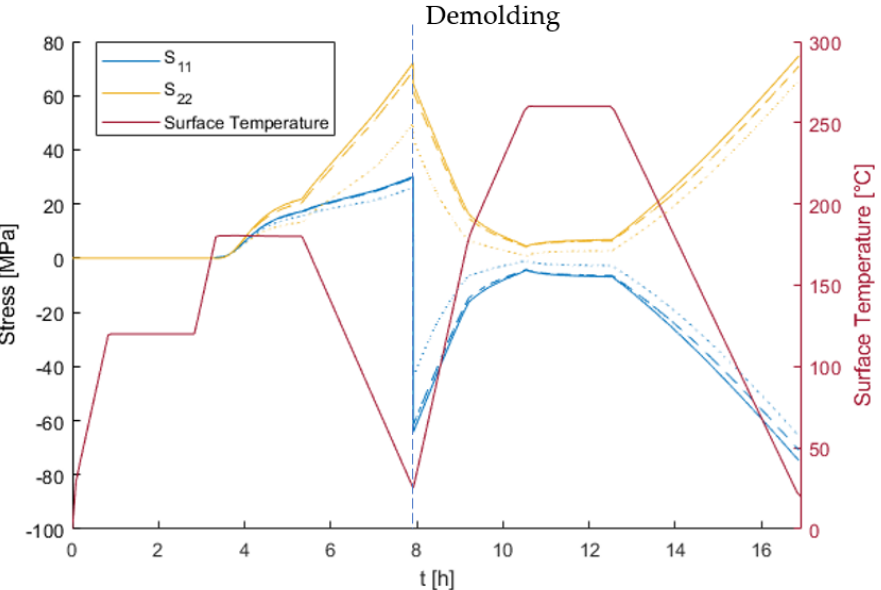
Figure 11. In-plane stress components in the 0° layer. The solid line is the elastic solution, the dashed line is the viscoelastic solution of the fully cured sample, and the dotted line is the viscoelastic solution with cure dependency. Since the layup was chosen to be quasi-isotropic, no remarkable difference was found for all other layers.